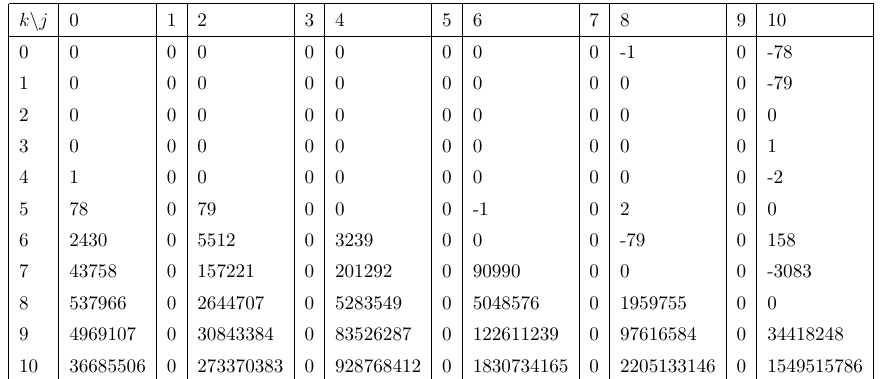
Table 86. Table of b jk coe(cid:14)cients for h E 7